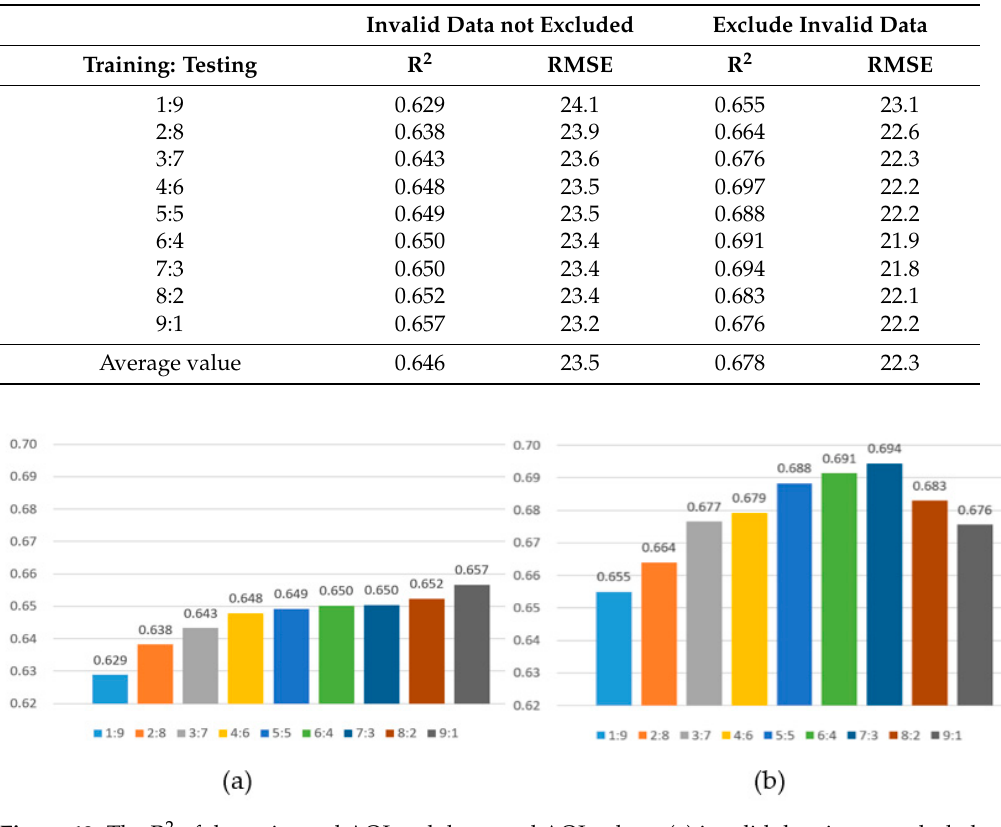
Figure 13. The R 2 of the estimated AQI and the actual AQI values; ( a ) invalid data is not excluded; ( b ) invalid data is